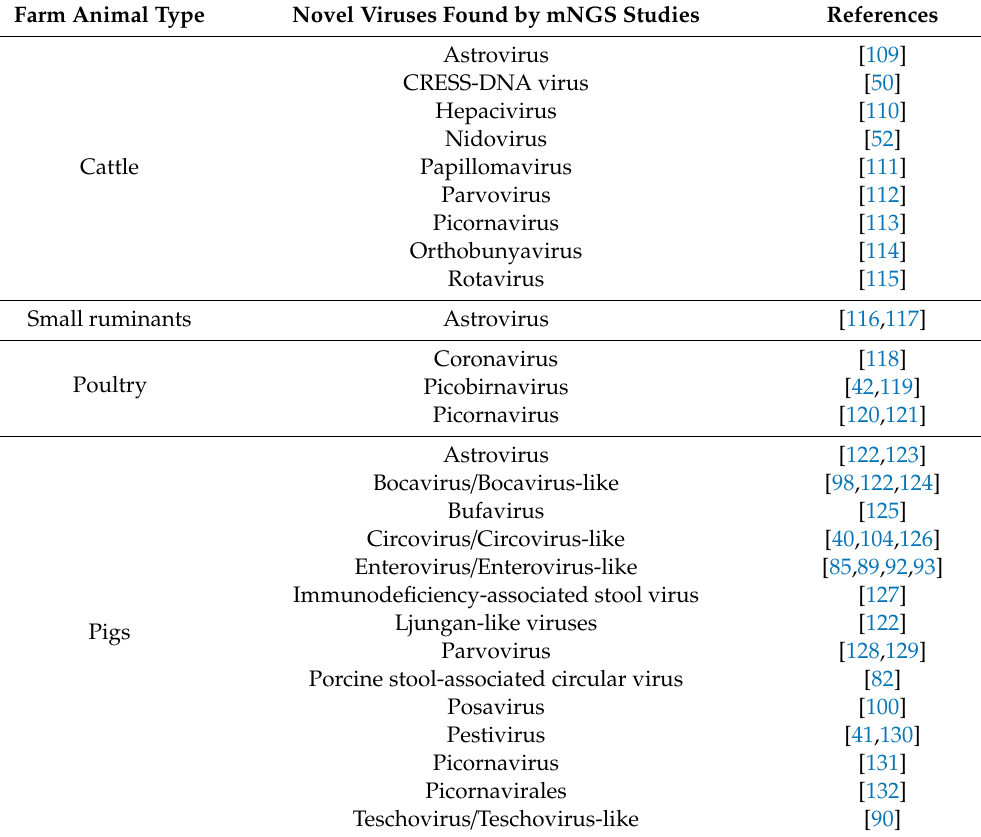
Table 2. Examples of novel viruses found in farm animals by available mNGS